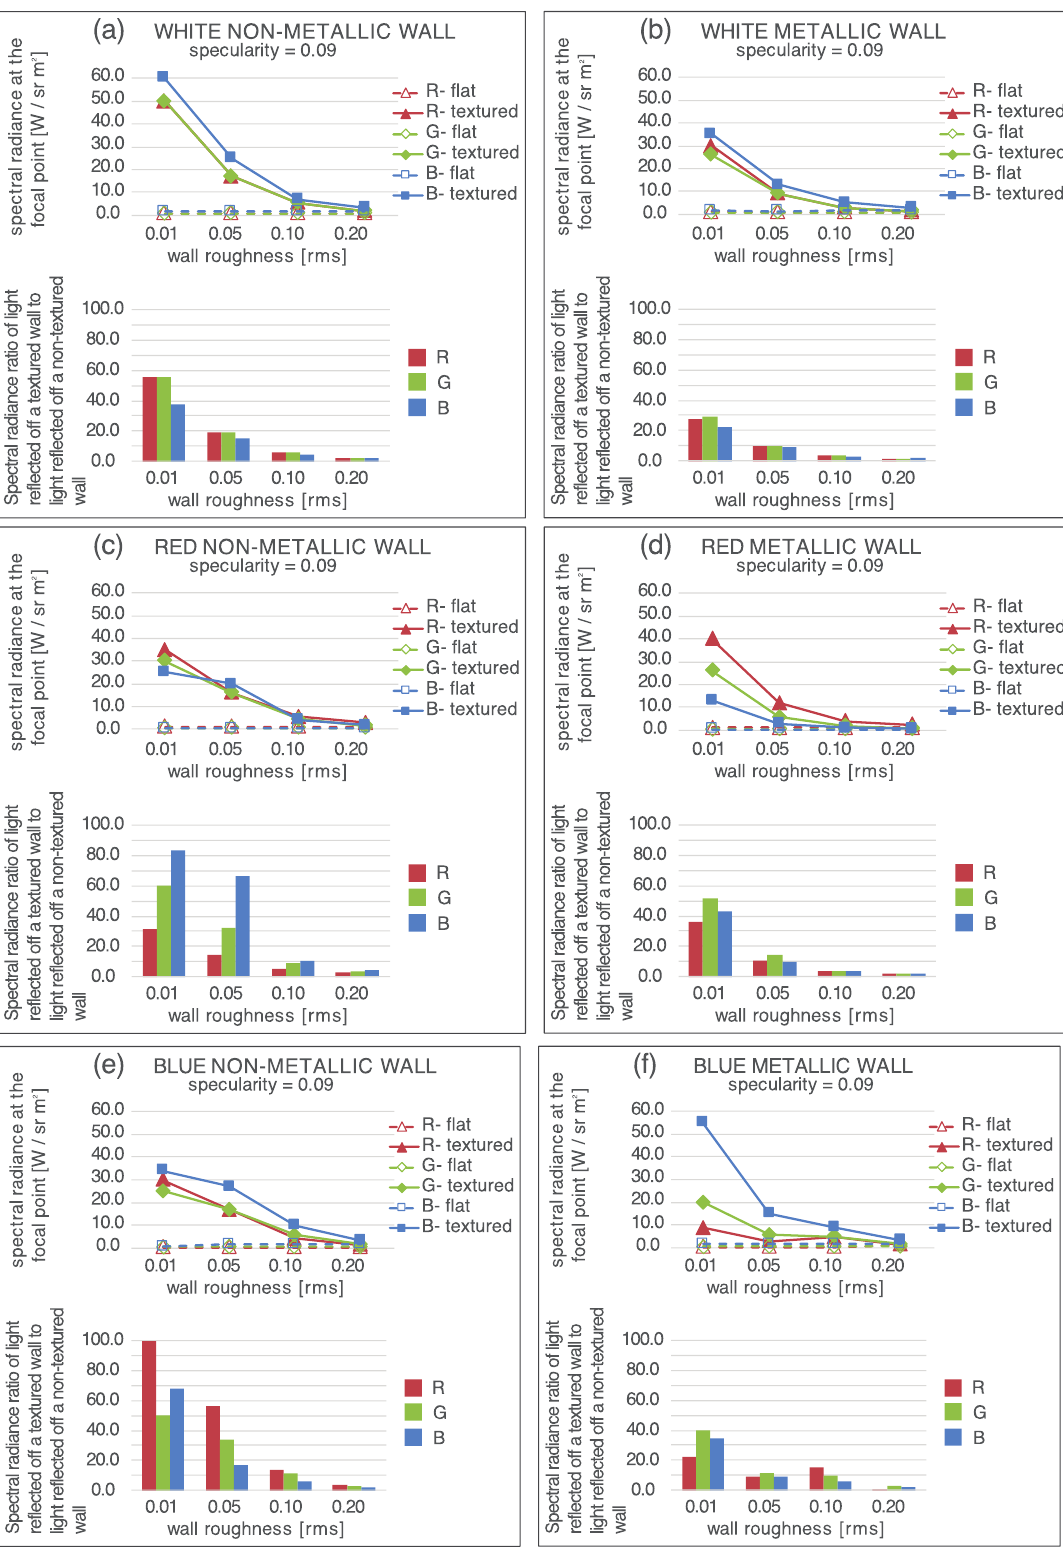
Figure 8. Spectral radiance values and spectral radiance ratios of light reflected off a textured active wall to light reflected off a non-textured active wall with a 0.09 specularity and a 0.01–0.20 range roughness. In relation to the reflected light red spectrum, highest radiance values at the focal point were reported in the following cases: